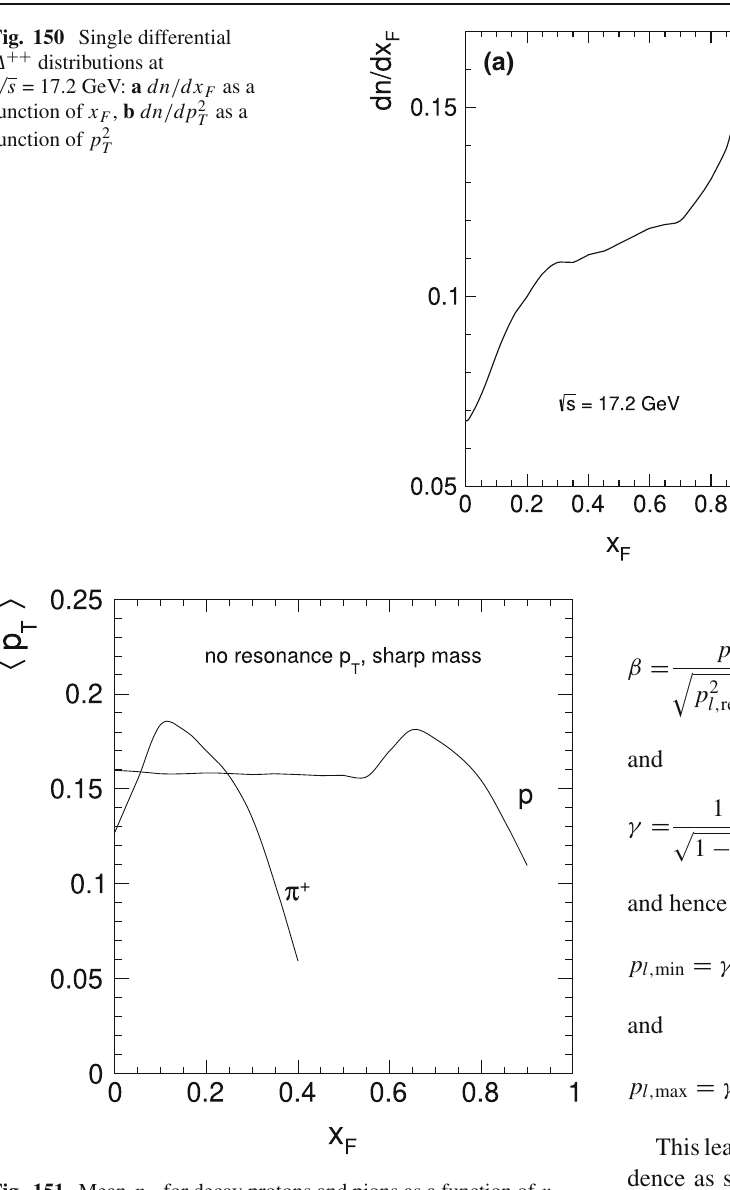
Fig. 151 Mean p T for decay protons and pions as a function of x